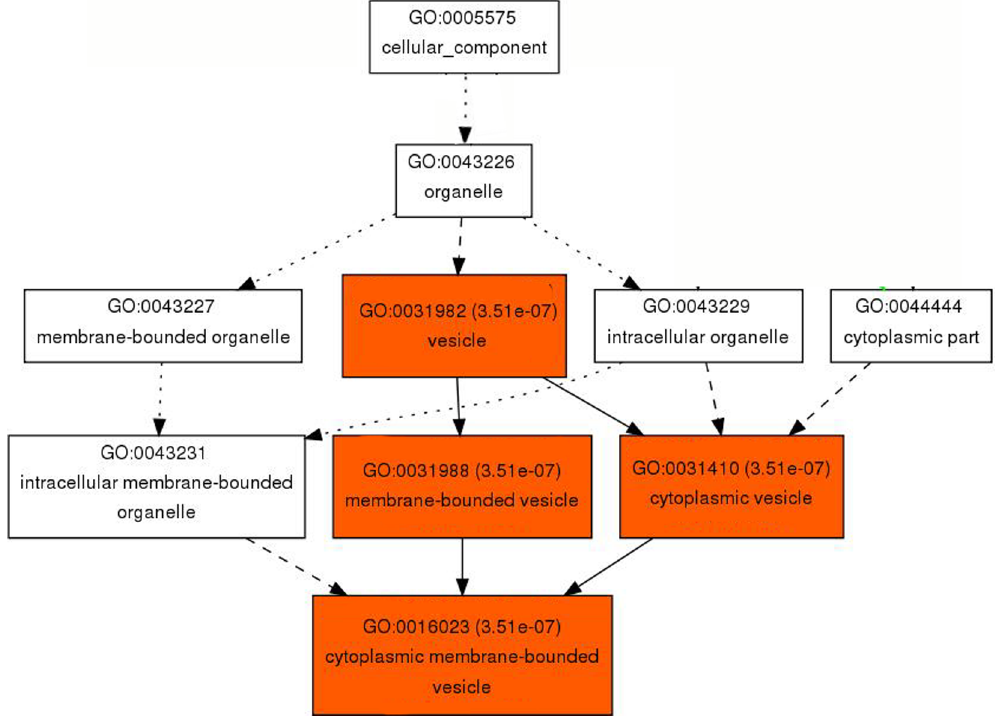
Figure 5. Identification of a potential cellular component in Li 1 and Li 2 mutants. AgirGo SEA analysis identified that nine of the DEGs presented in Table 1 were involved in vesicle transportation. The significant terms (adjusted P # 0.05) were shown in red color boxes, whereas non- significant terms were shown as white boxes. Solid, dashed, and dotted lines represented two, one and zero enriched terms at both ends connected by the line, respectively.